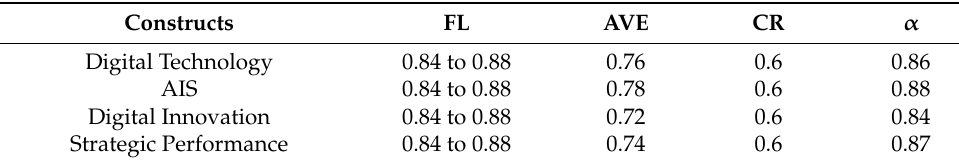
Table 5. Results of FL, AVE, CR, and